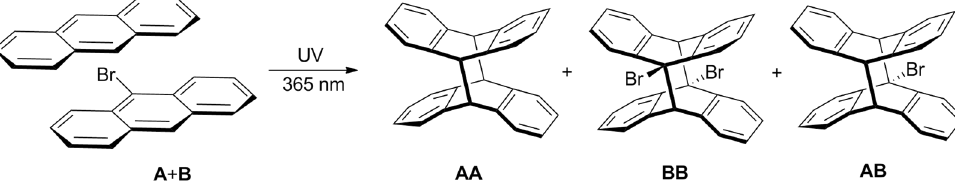
Figure 6. Photodimerization of anthracene and 9-bromoanthracene in the mixture. The reaction gives three possible products as a dimer AA , AB and BB .